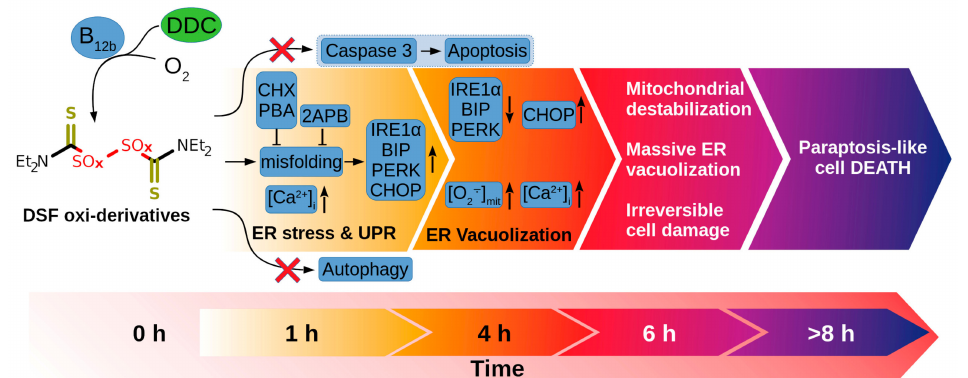
Figure 12. A hypothetic scheme of intracellular events during the initiation of paraptosis-like tumor cell death by the combination DDC + B 12b (for details, see the